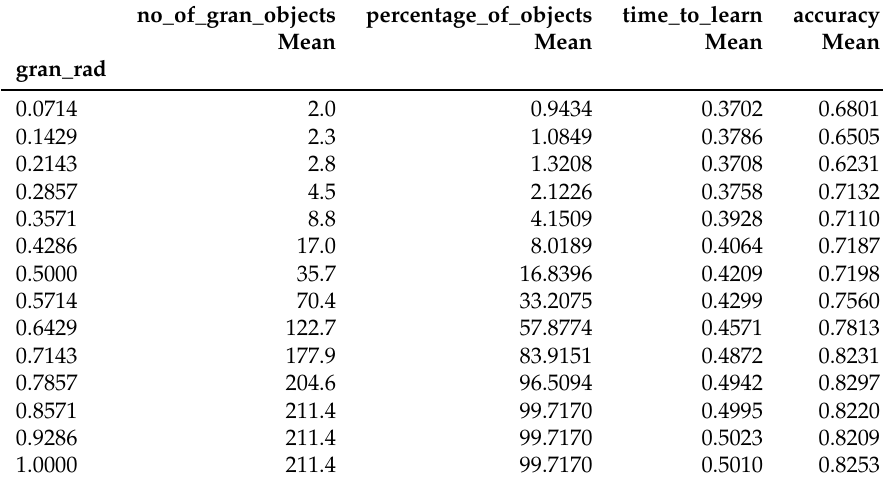
Table 6. Results for Heart disease dataset (mean from 10 experiments).